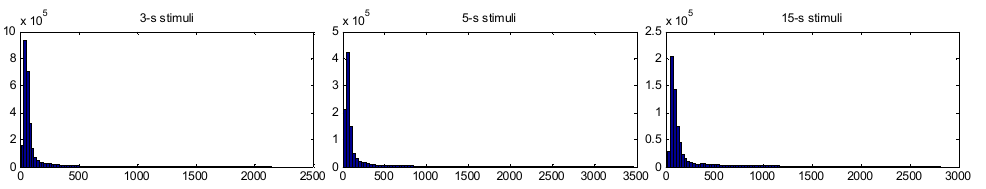
Figure 9. Average distance evaluated for the male participants and for the left ( a ) and right Parieto ‐ Temporal EEG channels as a function of stimulation color. ( b ) Parieto-Temporal EEG channels as a function of stimulation color.